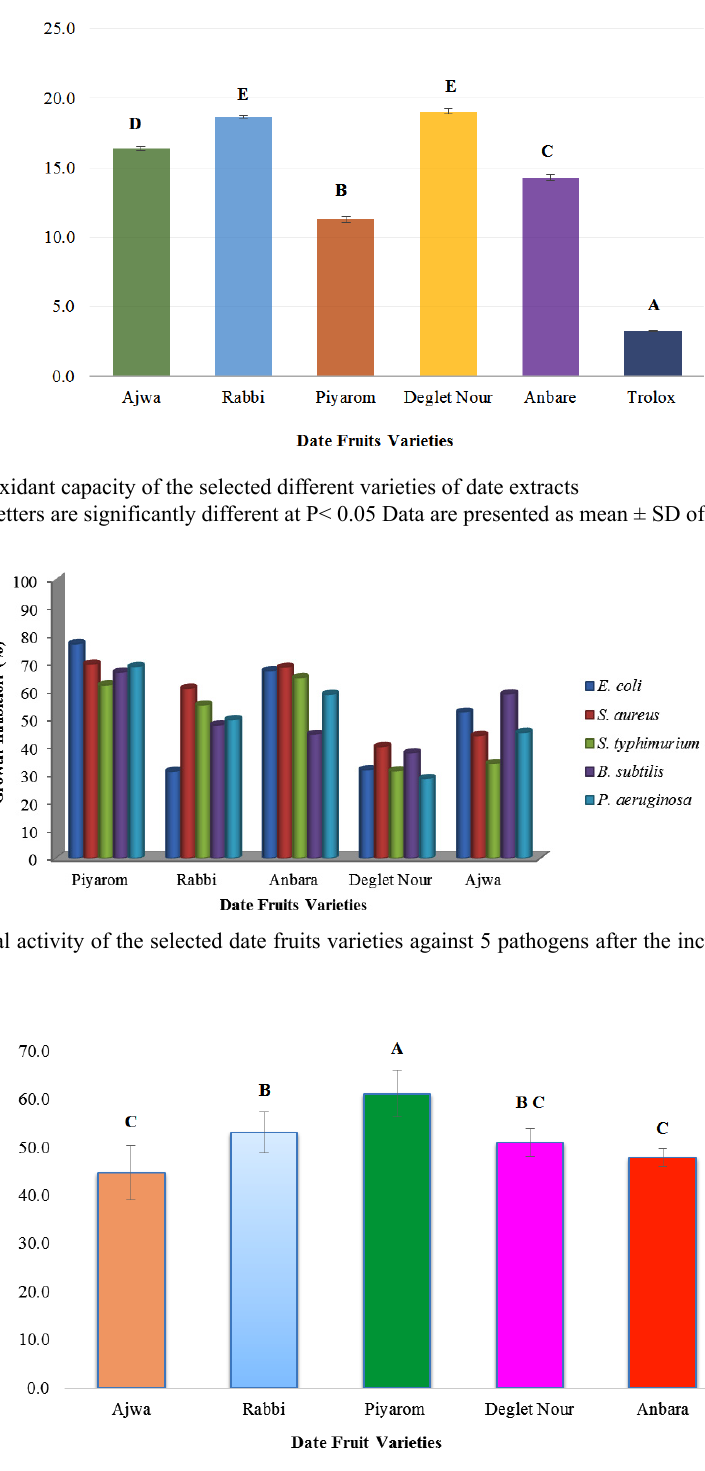
Fig. 3. The elastase inhibition activity of the selected varieties of date